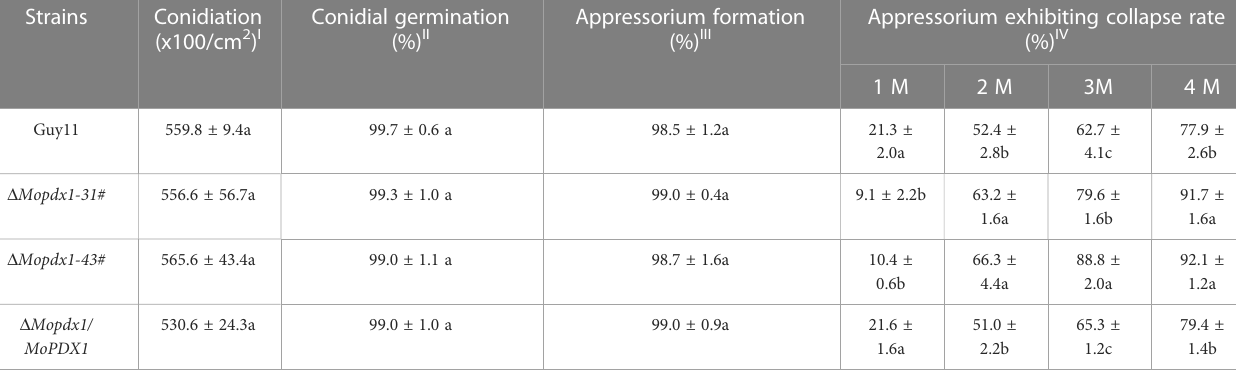
TABLE 2 Conidiation, conidial germination, appressorium formation, and turgor pressure assays of the wild type, D Mopdx1 mutant, and the complement strains.